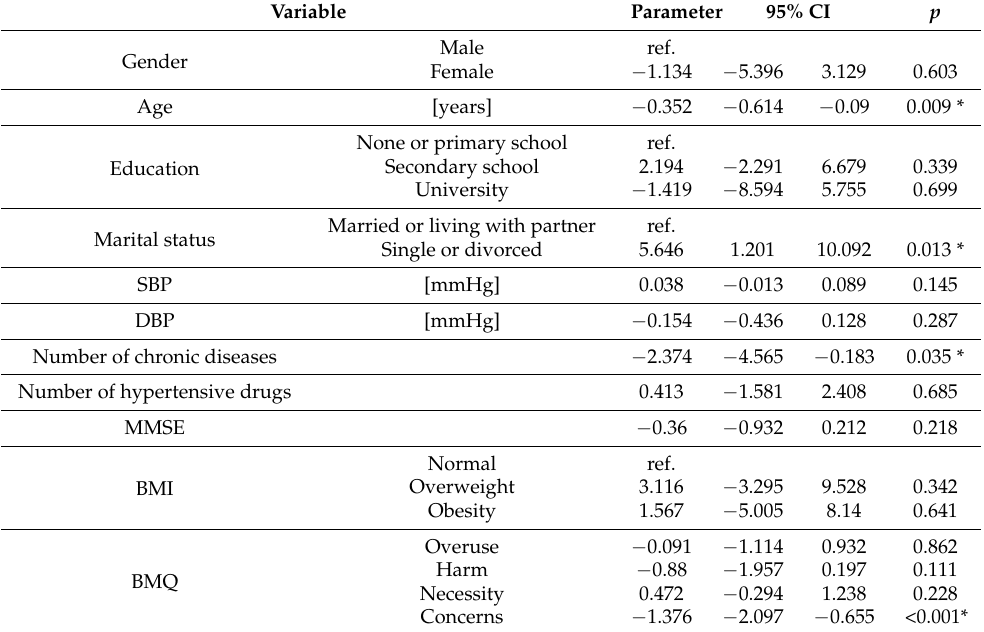
Figure 1. Correlation of BMQ domains with INAS. Table 3. Results of linear regression